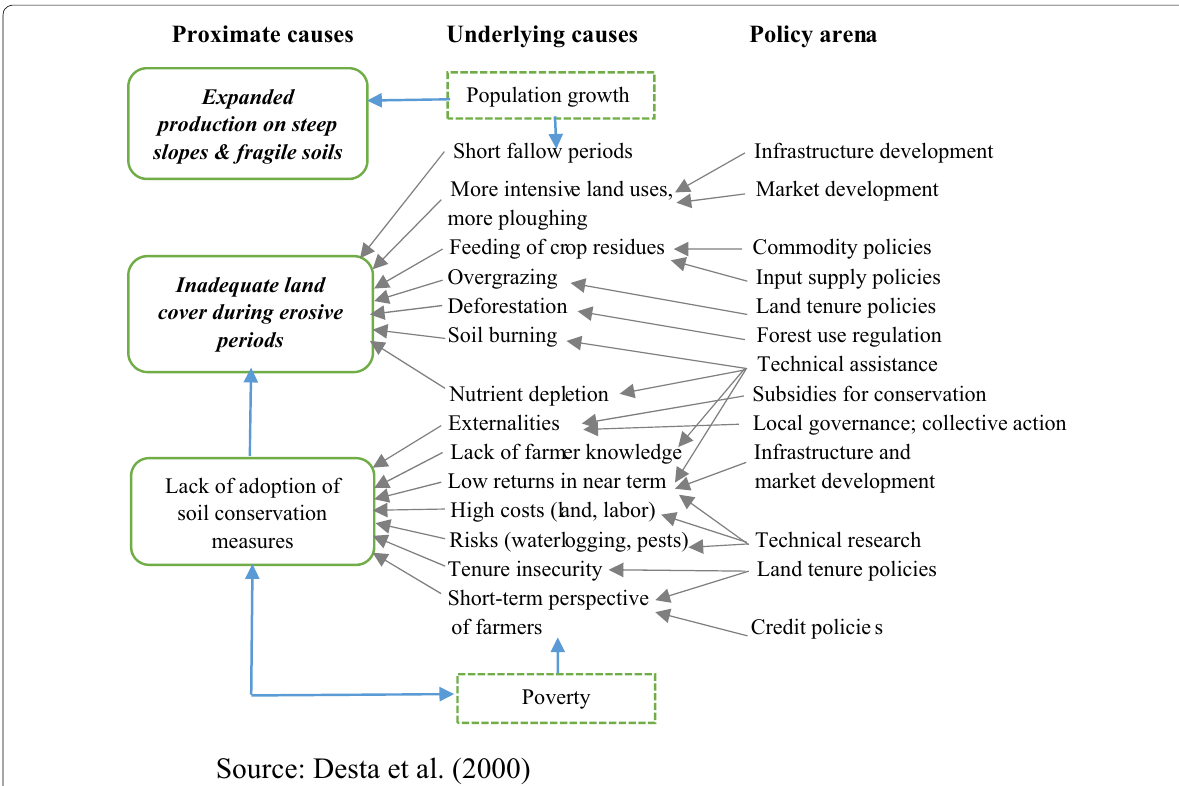
Fig. 2 Causes of soil